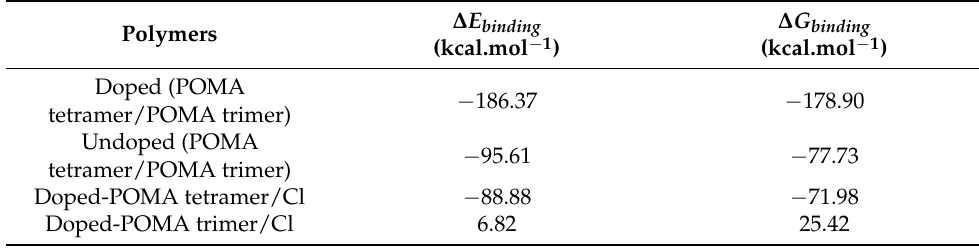
Table 3. Binding energy ( ∆ E binding ) and Gibbs free energy of binding ( ∆ G binding ).